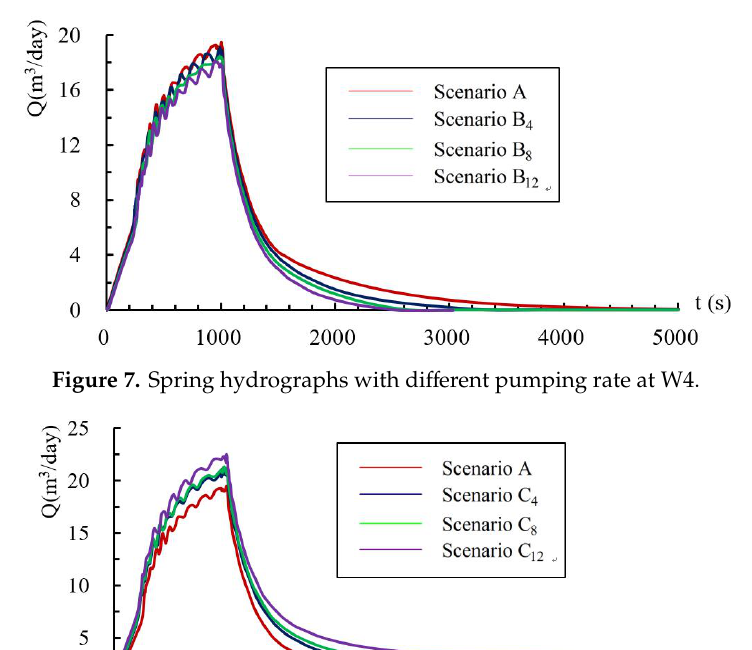
Figure 9. Spring hydrographs with different injection rate at W3.